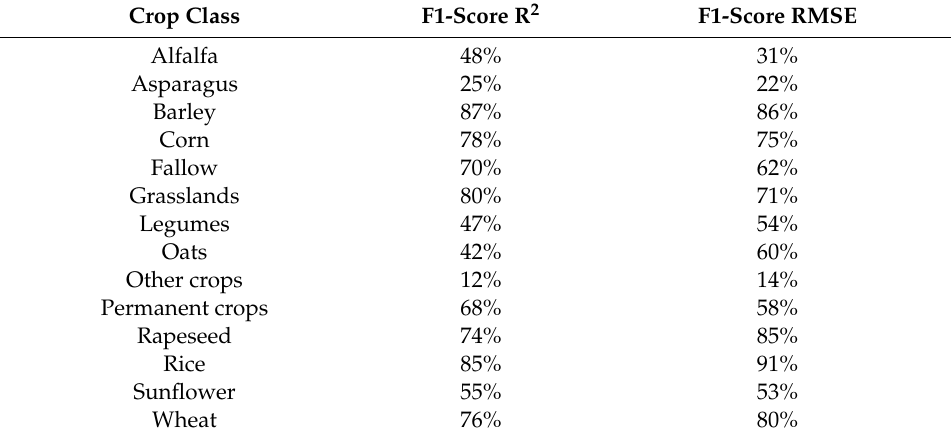
Table 5. F1-score of crops for Ens scheme in Navarre using R 2 and RMSE fit